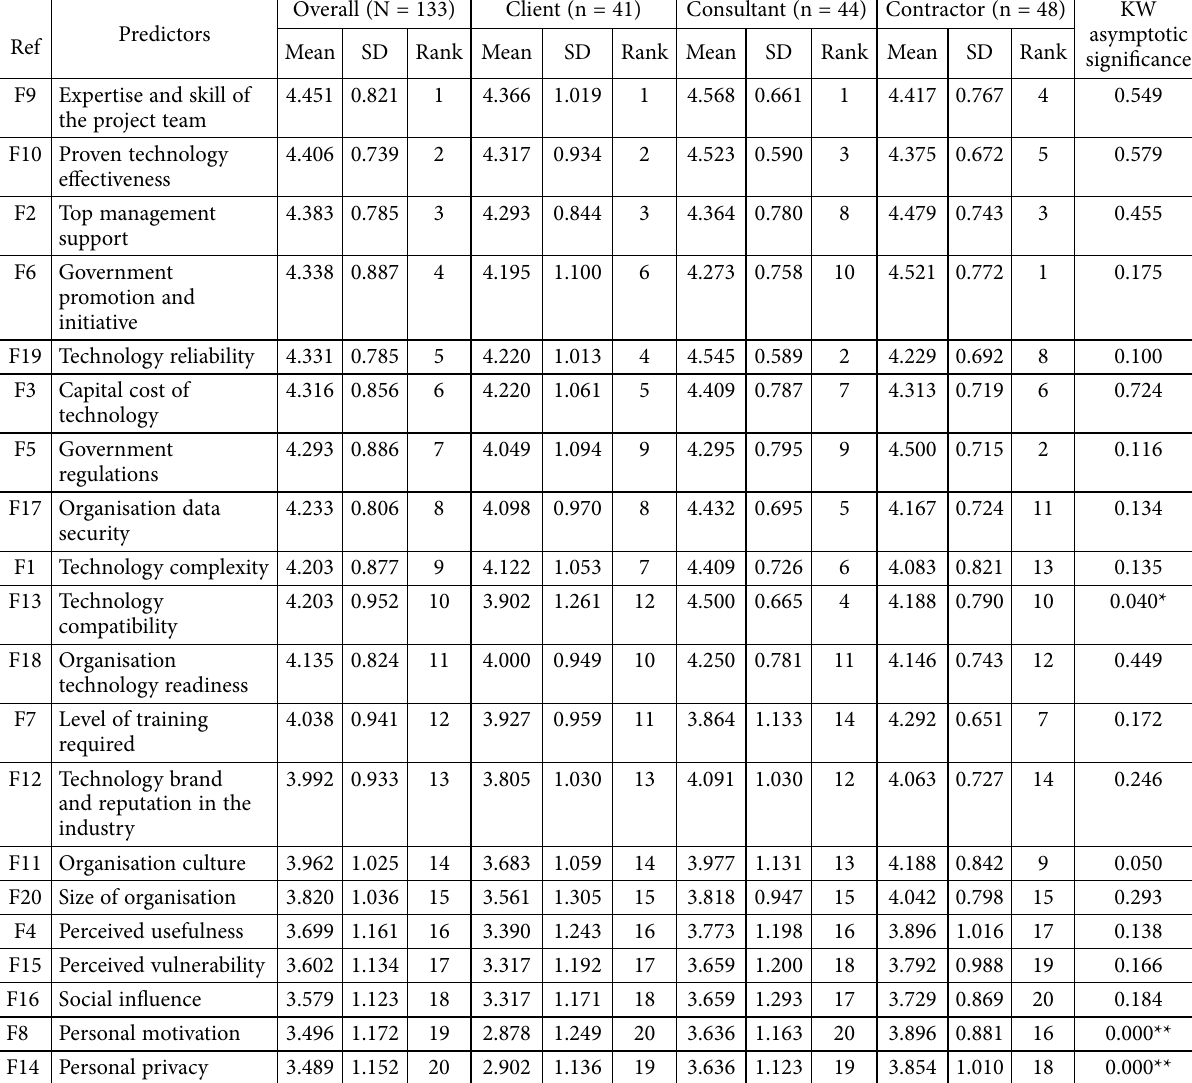
Table 4. Mean and ranking of predictors of safety technologies adoption in construction projects